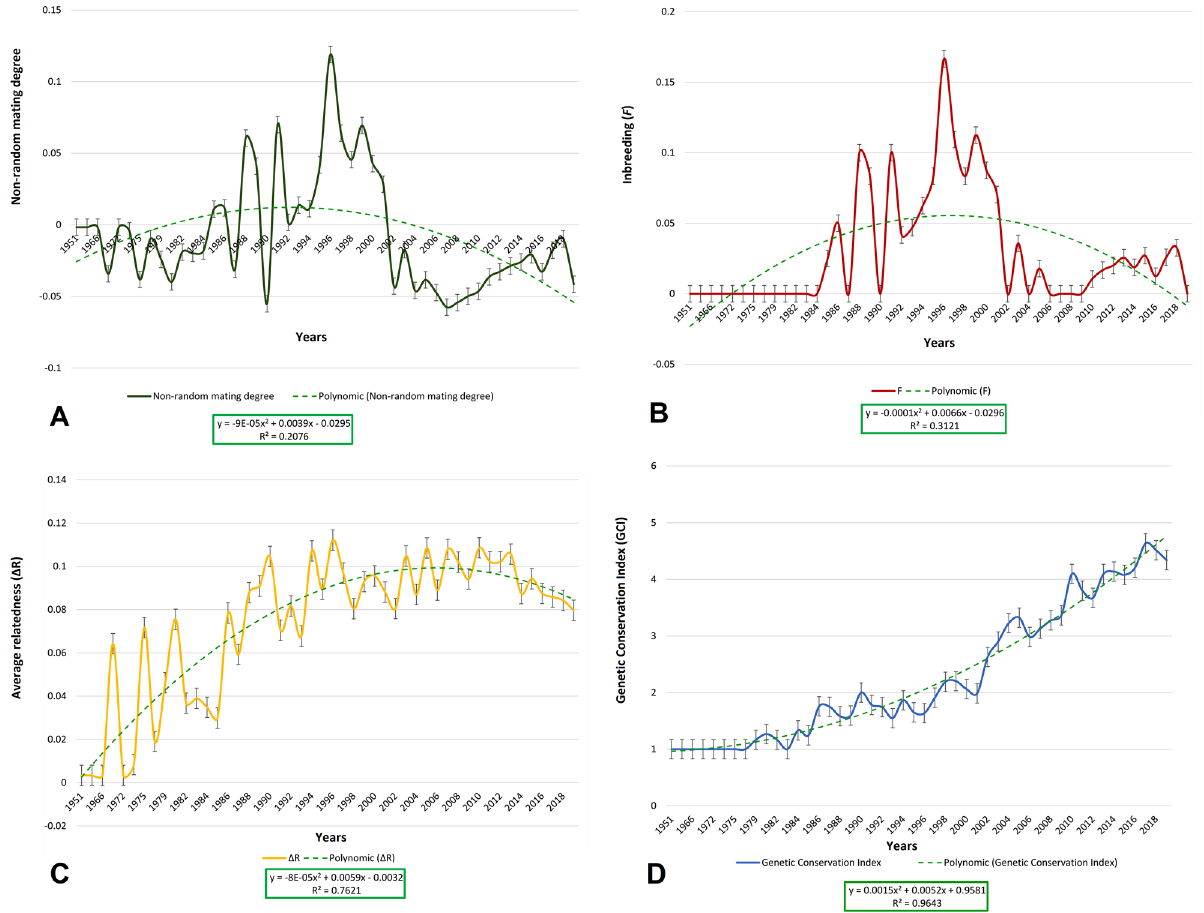
Figure 3. Evolution of ( A ) non-randon mating degree ( α ), ( B ) inbreeding rate ( F ), ( C ) average relatedness (Δ R ) and ( D ) Genetic Conservation Index (ICG) for the white-naped mangabey captive population from 1951 to 2019. Provided we measured the variability of time-series data, we relied on the standard error of the mean (SEM) rather than the standard deviation (SD), as it removes variability imposed by the trend in the data, which the SD does